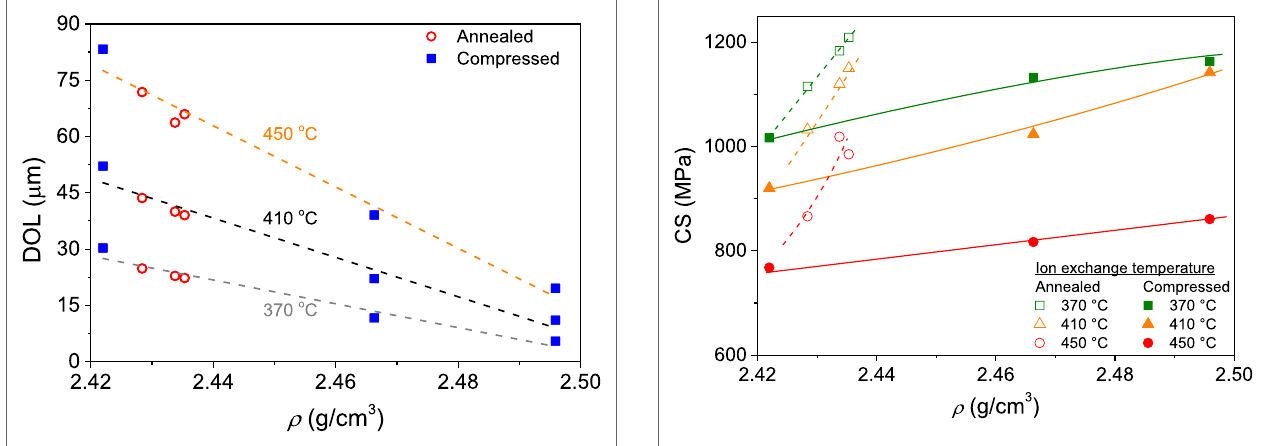
FigUre 5 | Dependence of depth of layer (DOl) on density ( ρ ) for the samples ion exchanged at three different temperatures (370, 410, and 450°c) . The range of density values has been obtained by annealing and isostatic compression.